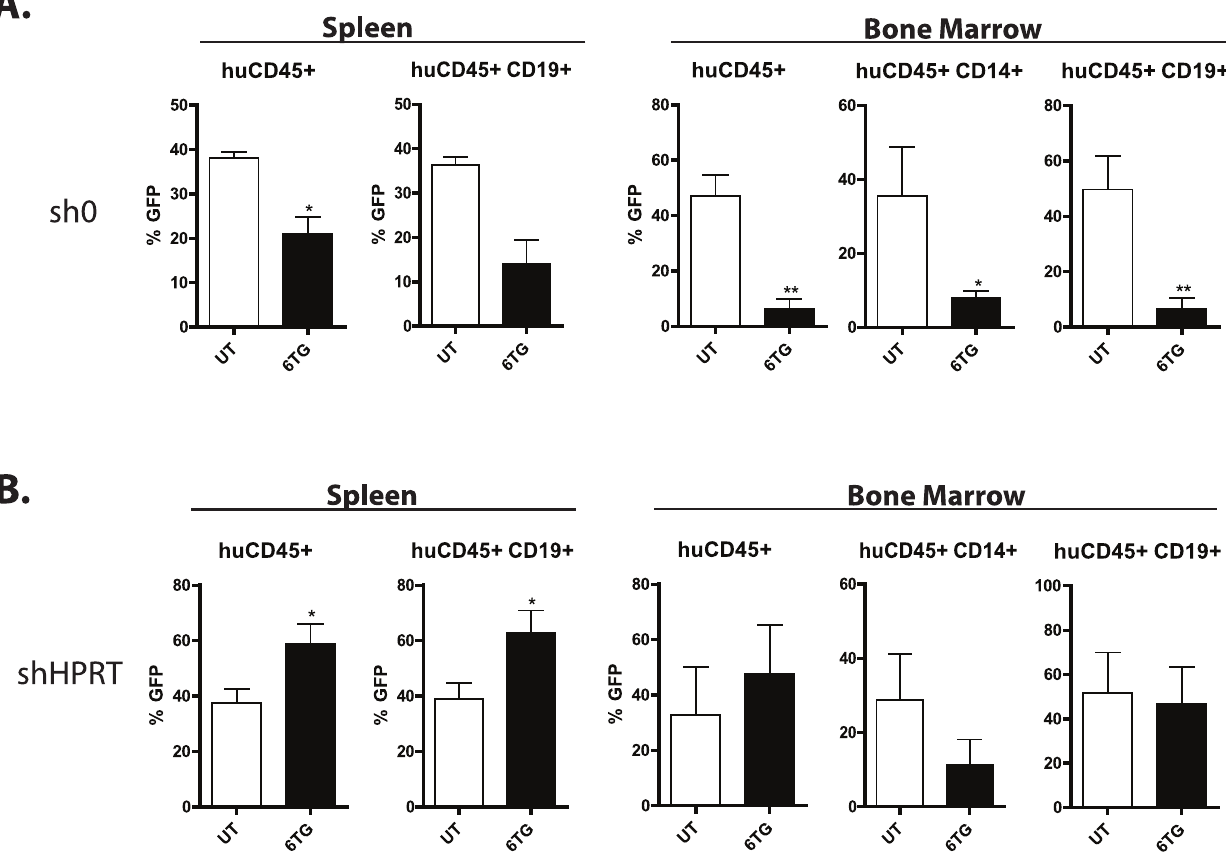
Figure 3. Knockdown of HPRT protects human cells from the toxic effects of 6TG in vivo. Human CD34 + umbilical cord blood cells were transduced with GFP expressing vectors with non-silencing shRNA ( A ) or shRNA directed against HPRT ( B ) and transplanted into sub-lethally irradiated recipients. Mice were then treated with 6TG 2 mg/kg/d in the drinking water or left untreated. After 6 weeks, the spleens and bone marrow were analyzed by flow cytometry for cell surface markers for total human leukocytes, B-lymphocyte and myeloid subpopulations, and GFP. A. Cells transduced with non-silencing control were selectively depleted with treatment with 6TG. The percentages of GFP + human leukocytes (huCD45 + ), B- lymphocytes (huCD45 + CD19 + ), and myeloid cells (huCD45 + CD14 + ) from the spleen and bone marrow are depicted. There were 2 untreated and 5 6TG treated mice in this experiment. B. Cells transduced with shRNA directed against HPRT are protected from the cytotoxic effects of 6TG. The percentages of GFP + cells are depicted as in 3A. Note the significant increase in the percentage of GFP + human cells in the spleen and maintenance of the percentage of GFP + human cells in the bone marrow. There were 5 mice per group in this experiment.